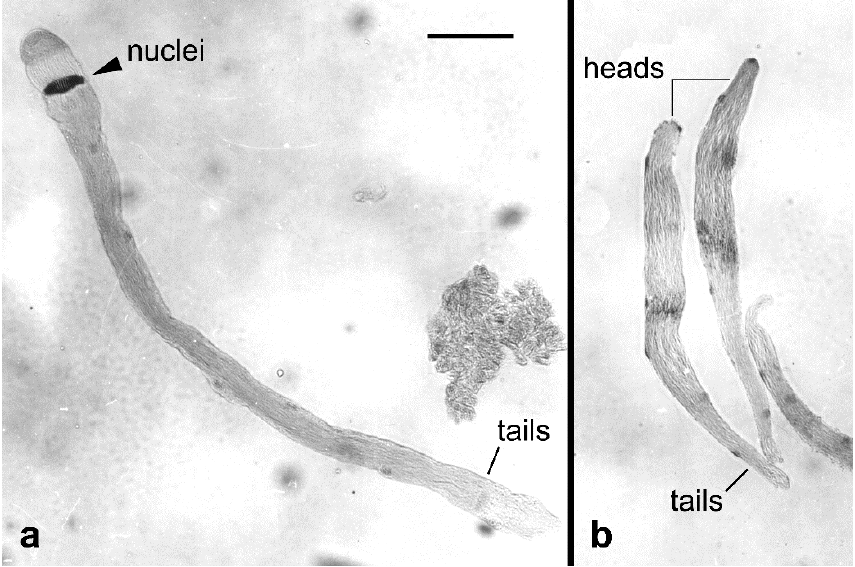
Figure 4. Sperm bundles in the Mediterranean flour moth, Ephestia kuehniella Zeller, stained with lactic acetic orcein. ( a ) A eupyrene sperm bundle. ( b ) Two apyrene sperm bundles. Bar = 100 µm.